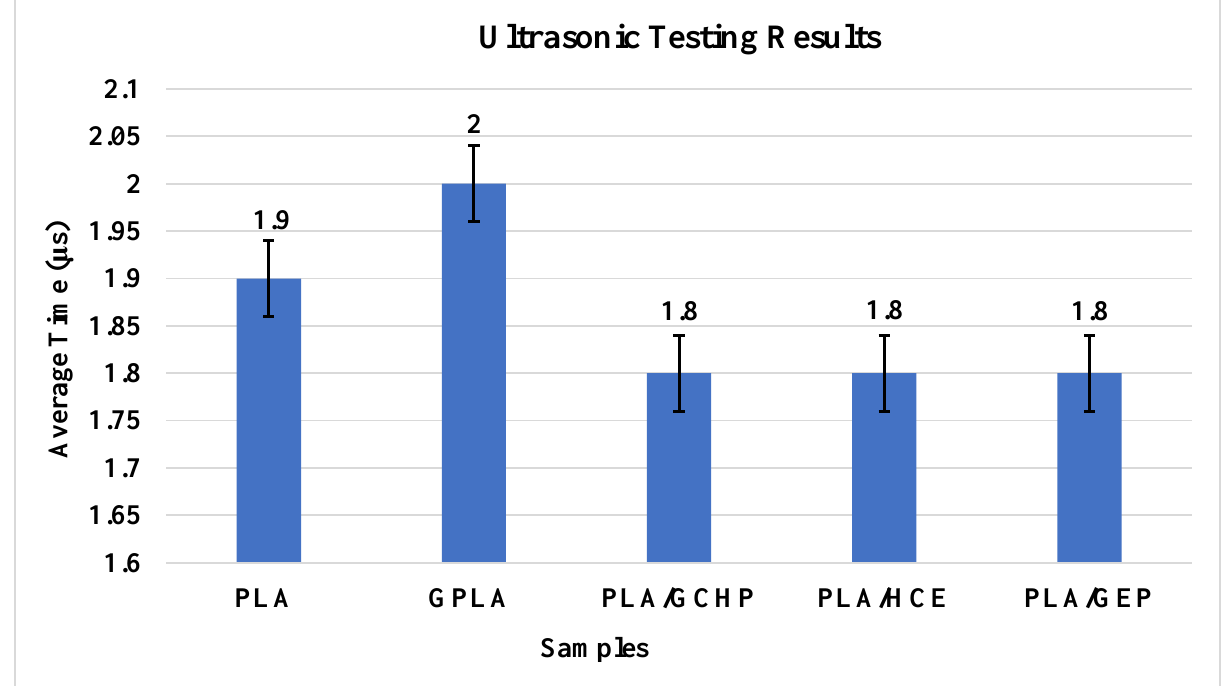
Figure 5. Results from ultrasonic testing.